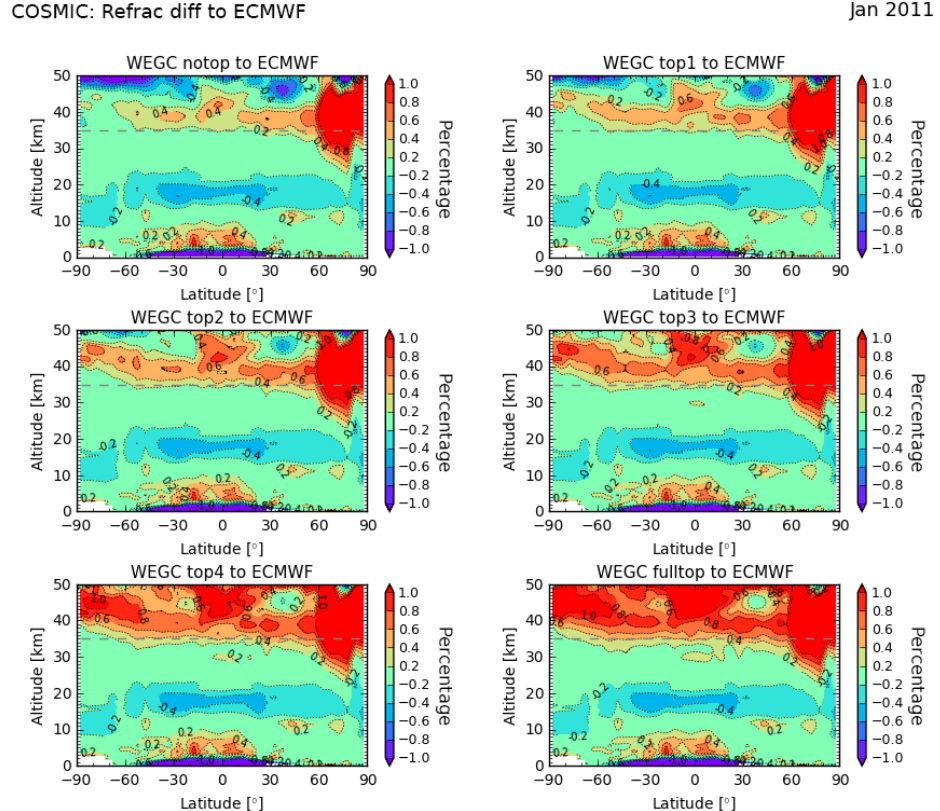
Figure 9. Sensitivity of API refractivity climatologies relative to different handling of the high-altitude extrapolation, analyzed against ECMWF analyses. The plots start from a top value of zero (notop) and increase in incremental steps of 1 / 5 (top1, top2, top3, top4) to the full value